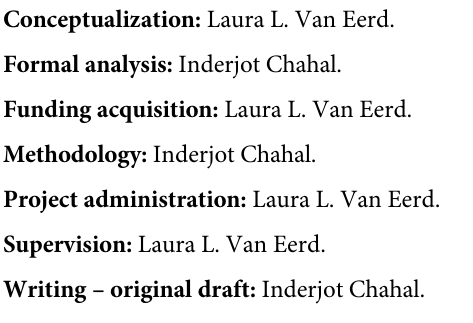
S5 Table. In a medium-term cover crop experiment, Spearman correlation coefficients between soil labile and stable fractions of C and N sampled from 0–15 cm depth in 2015. � Significant correlation at P < 0.05. Cmin , cumulative 2d soil carbon mineralization; MBC, 2d microbial biomass C; MBN, microbial biomass N; SLAN, Solvita labile amino N; OC, soil organic C; WAS, wet aggregate stability; WEOC, water extractable organic C; WEON, water extractable organic N. S6 Table. In a medium-term cover crop experiment, Spearman correlation coefficients between soil labile and stable fractions of C and N sampled from 0–15 cm depth in 2016. � Significant correlation at P < 0.05. Cmin , cumulative 2d soil carbon mineralization; MBC, 2d microbial biomass C; MBN, microbial biomass N; SLAN, Solvita labile amino N; OC, soil organic C; WAS, wet aggregate stability; WEOC, water extractable organic C; WEON, water extractable organic